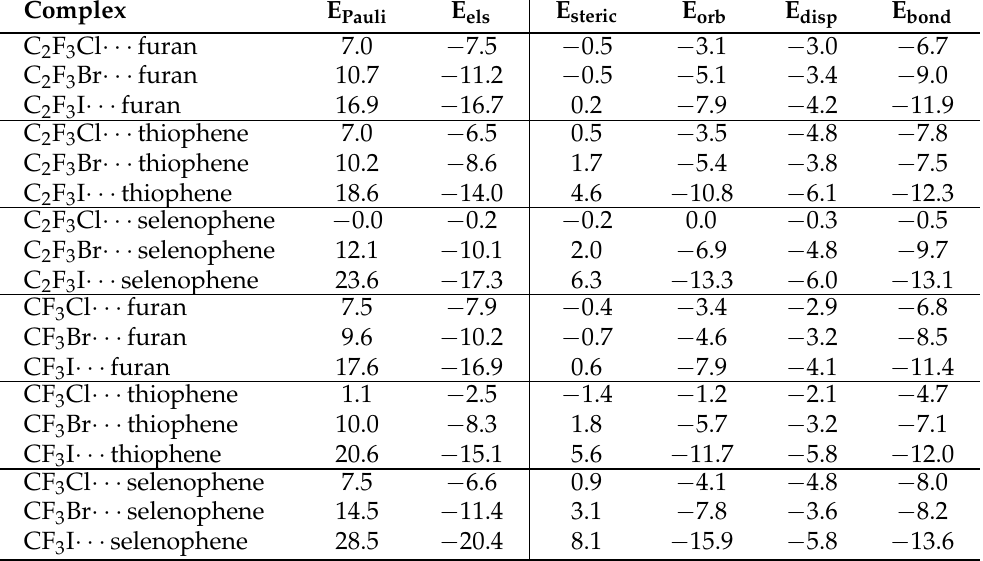
Table 4. Energy decomposition analysis (EDA) in kJ/mol for the parallel oriented complexes.